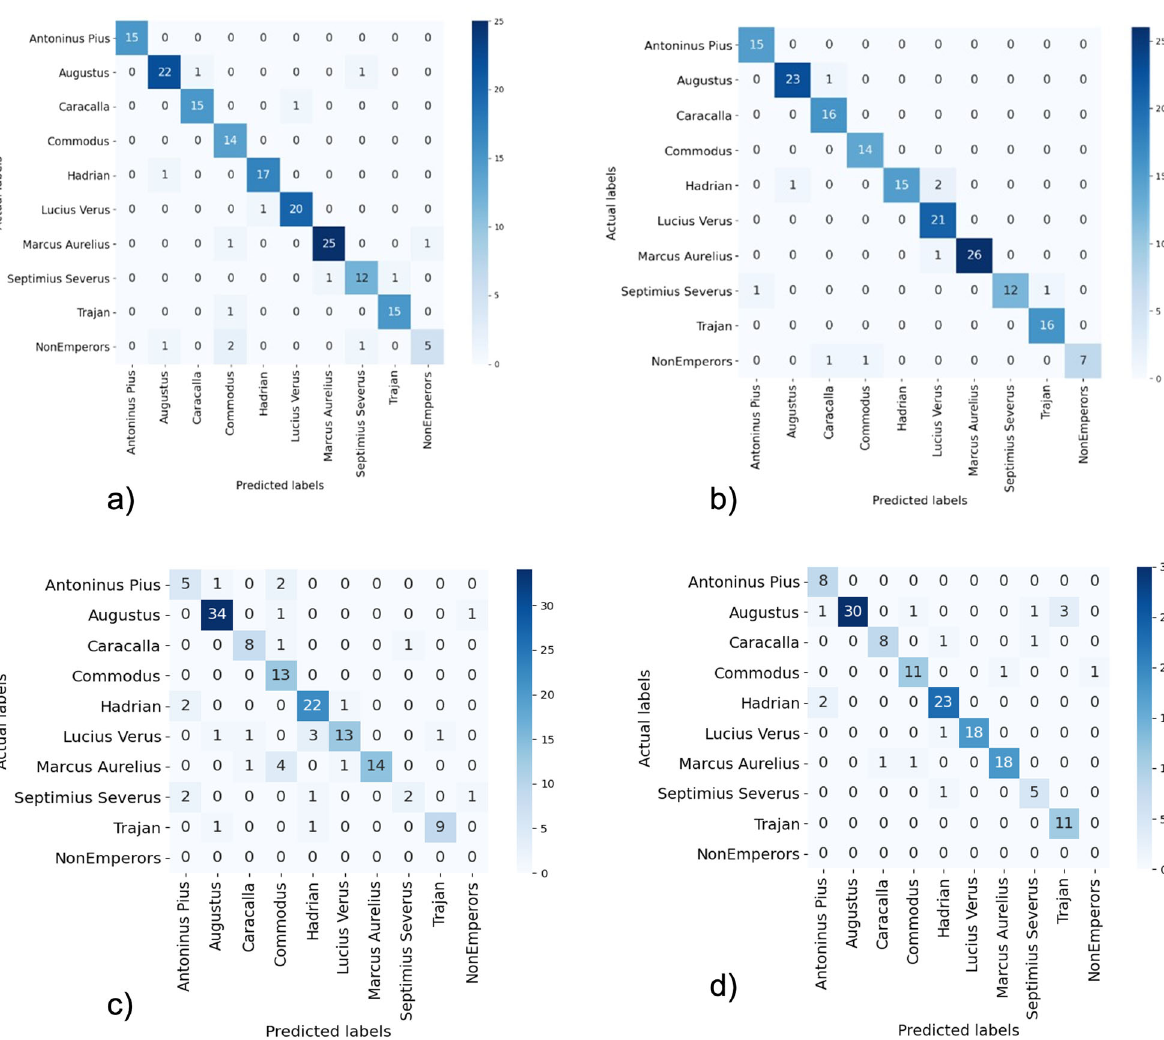
Fig. 8 Confusion matrices. a Experiment 1: validation set. b Experiment 2: validation set. c Experiment 1: test set. d Experiment 2: test set.